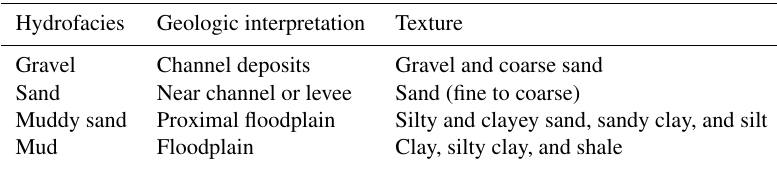
Table 1. Textural classification of hydrofacies designations (Fleckenstein et al., 2004). Hydrofacies Geologic interpretation Texture Gravel Channel deposits Gravel and coarse sand Sand Near channel or levee Sand (fine to coarse) Muddy sand Proximal floodplain Silty and clayey sand, sandy clay, and silt Mud Floodplain Clay, silty clay, and